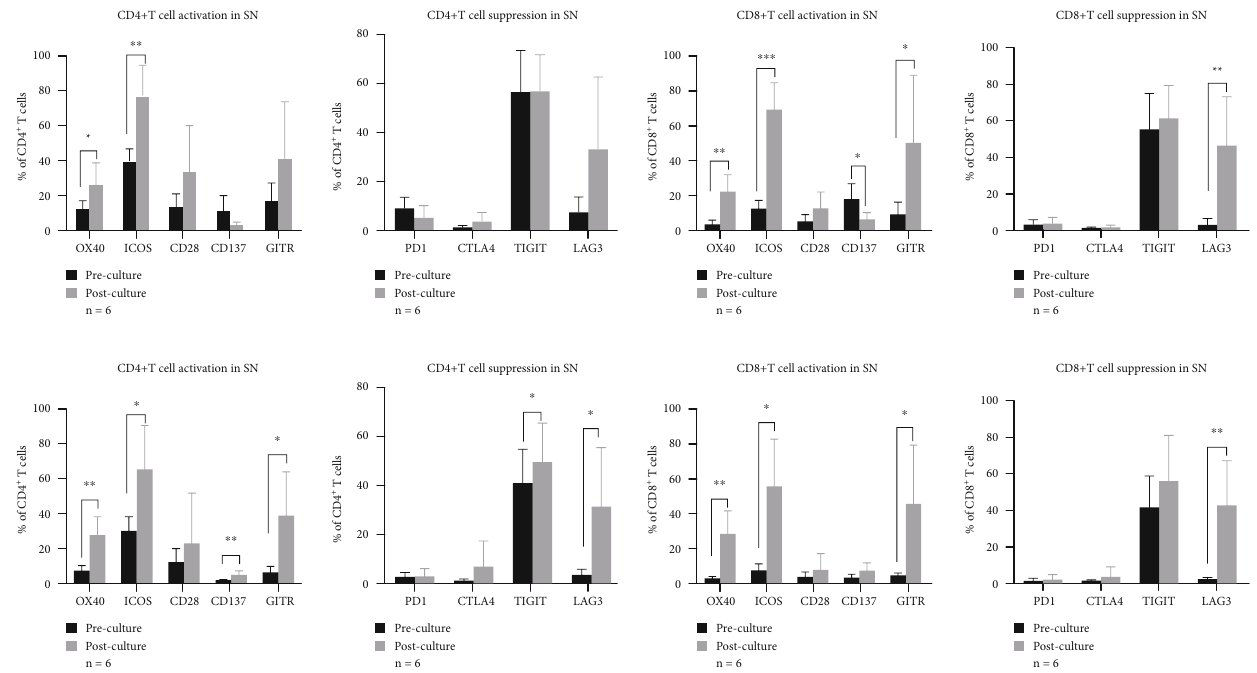
Figure 7: Changes in T cell function of SN and NSN caused by ex vivo culture. ∗ p < 0 : 05 , ∗∗ p < 0 : 01 , and ∗∗∗ p < 0 : 001